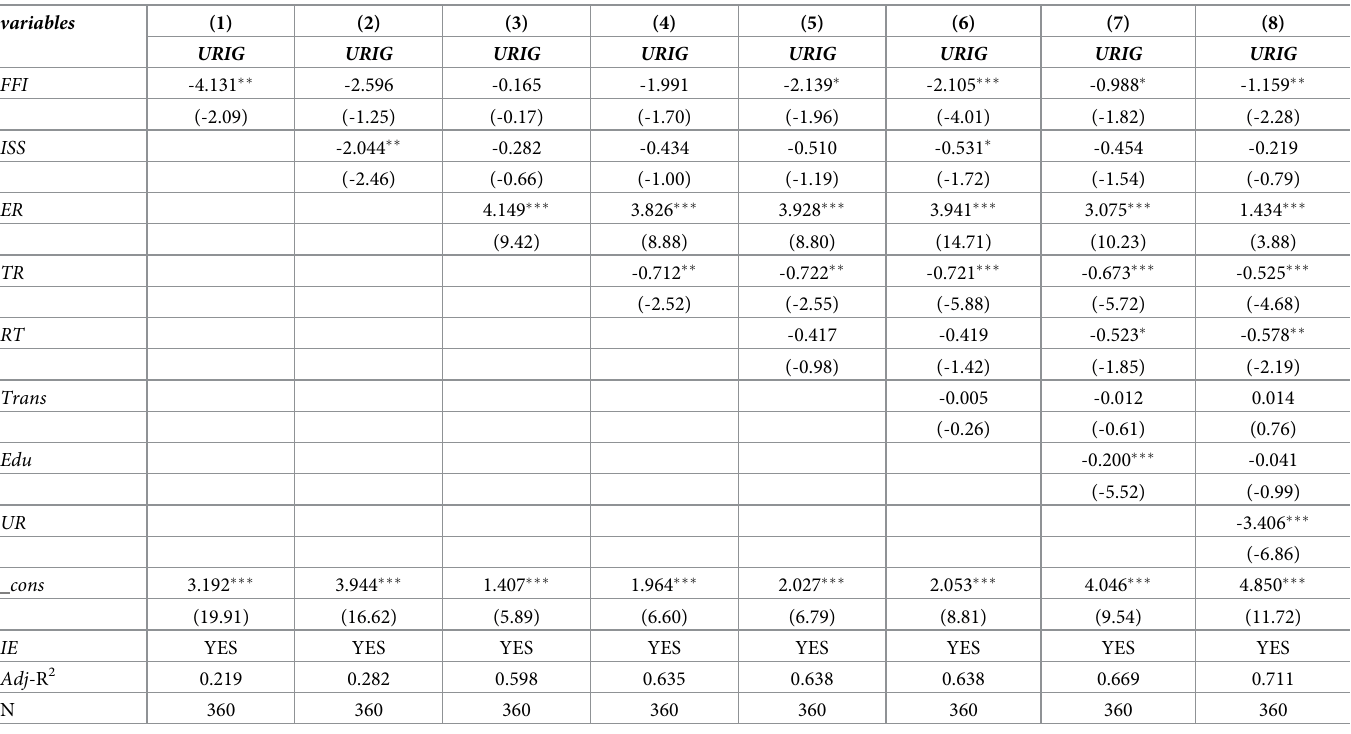
Table 8. Robustness test: Increasing possible missing variables.